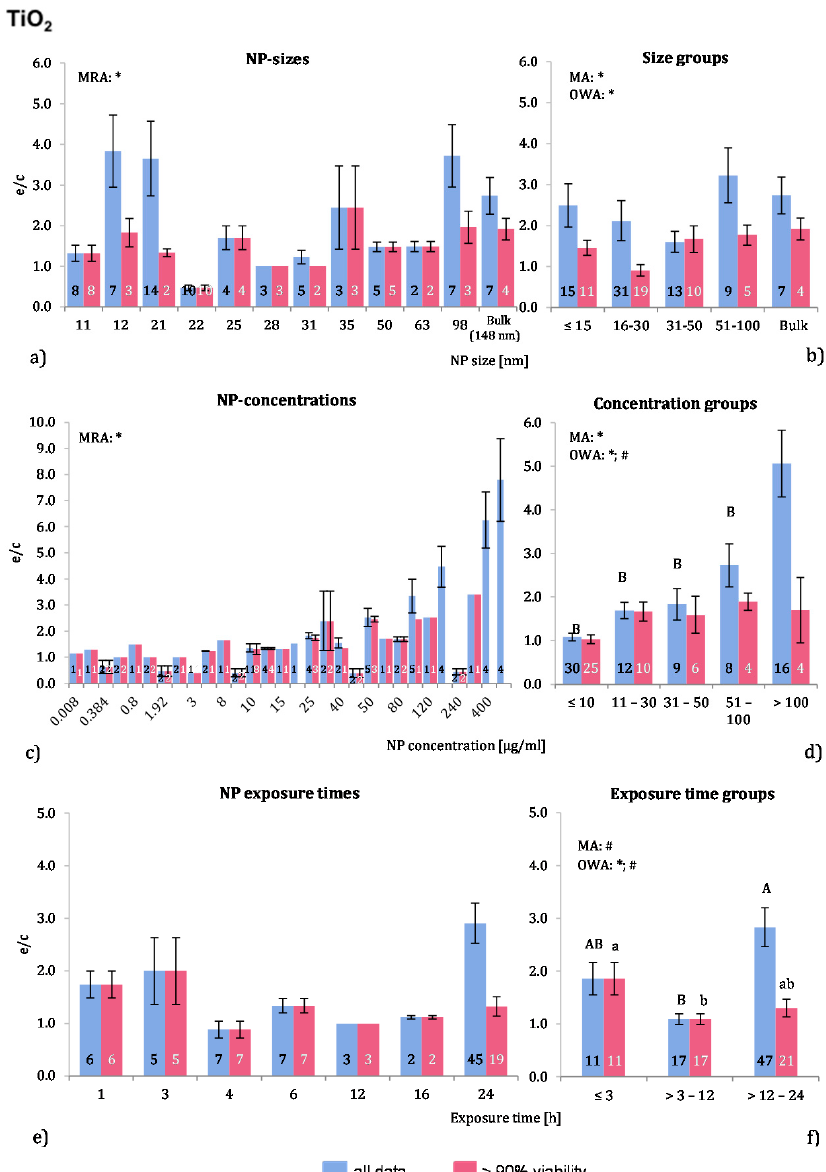
Figure 3. The effect of NP-size, concentration and exposure time on ROS ratios after exposure to TiO 2 -NP. Data are illustrated as mean ± SEM and numbers inside the bars represent the number of investigations. Mean ROS ratios as a function of ( a ) NP-size, ( c ) NP-concentration and ( e ) exposure times are shown. Multiple Regression Analysis (MRA) was used to identify correlations between the independent variables NP size, concentration or exposure time and the dependent variable ROS ratio; ( b , d , f ) show the respective groupings that were analyzed with multi-factor ANOVA (MA) for statistical significant inhomogeneity for three variables, one-way ANOVA (OWA) for one variable, and the modified post-hoc Tukey test for unequal n for group differences. The bars labelled “a” or “A” etc. are statistically different from “b” or “B” but not from “ab” or” AB”. p < 0.05 for * all data and # for >90% viability.